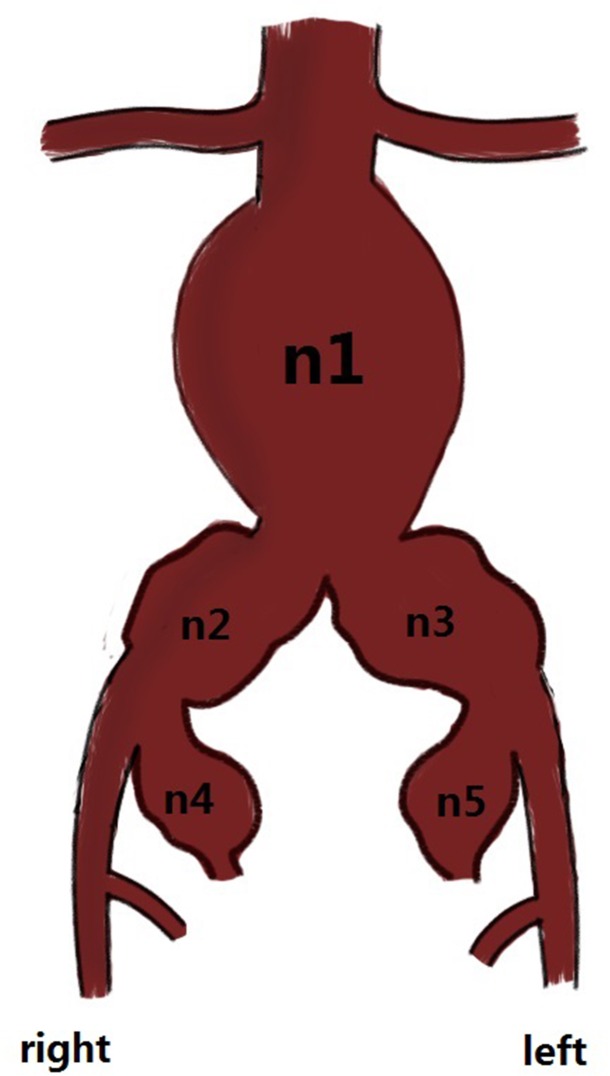
*n1: abdominal aortic aneurysm (AAA); n2: right common iliac artery aneurysm (CIAA); n3: left CIAA; n4: right internal iliac artery aneurysm (IIAA); and n5: left IIAA.*n1: 47; n1+2: 17; n1+3: 5; n1+4: 6; n1+5: 3; n1+2+3: 25; n1+2+5: 7; n1+2+4: 2; n1+3+4: 1; n1+3+5:1; n1+4+5: 3; n1+2+3+4: 4; n1+2+4+5: 2; n1+2+3+5: 5; and n1+2+3+4+5: 9. n1+2 represents an AAA that invaded the right common iliac artery; the others were considered likely. * Fig 2 is just an illustration; we cannot show the exact anatomical details.